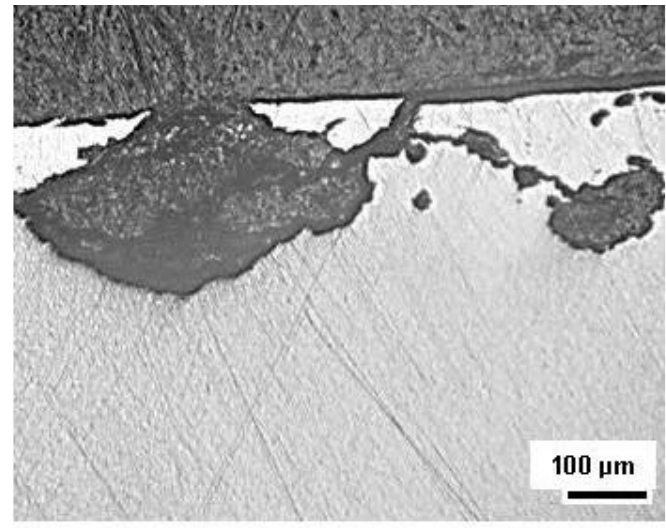
Figure 9. Subsurface corrosion damage on visually uncorroded